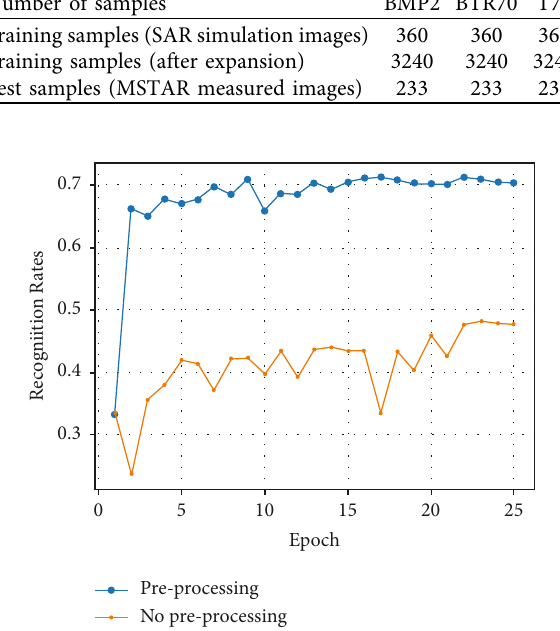
Figure 10: Nonhomologous SAR target recognition process based on CNN.